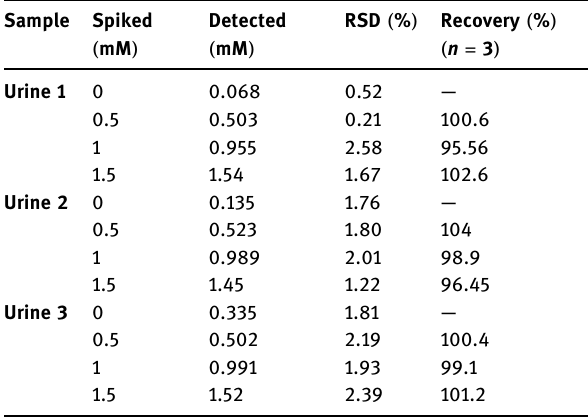
Table 1: Results of real sample analysis Sample Spiked ( mM )